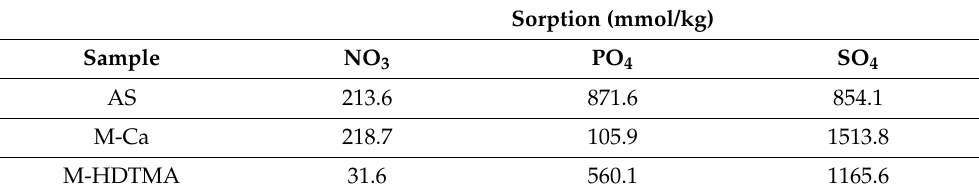
Table 6. Sorption values of NO 3 , PO 4 , and SO 4 in raw and modified samples.